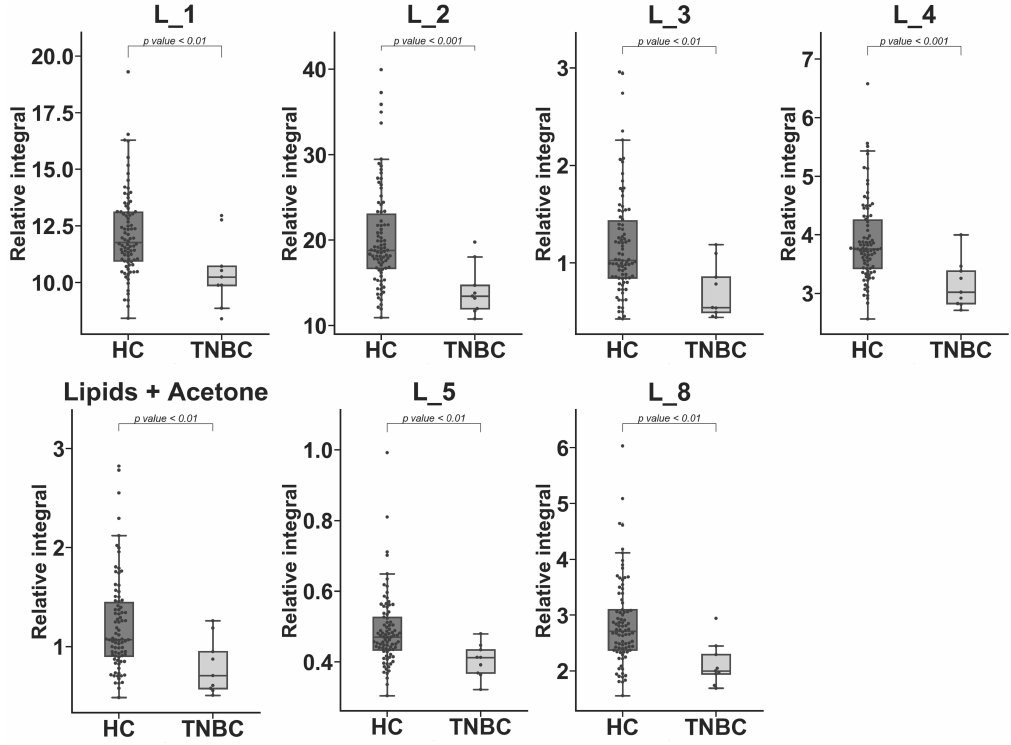
Figure 4. Statistically important lipid fragments identified in the HC vs. TNBC comparison but not identified in the cell line medium experiment. Whiskers = 1.5 × IQR; lines = average; boxes = interquartile range